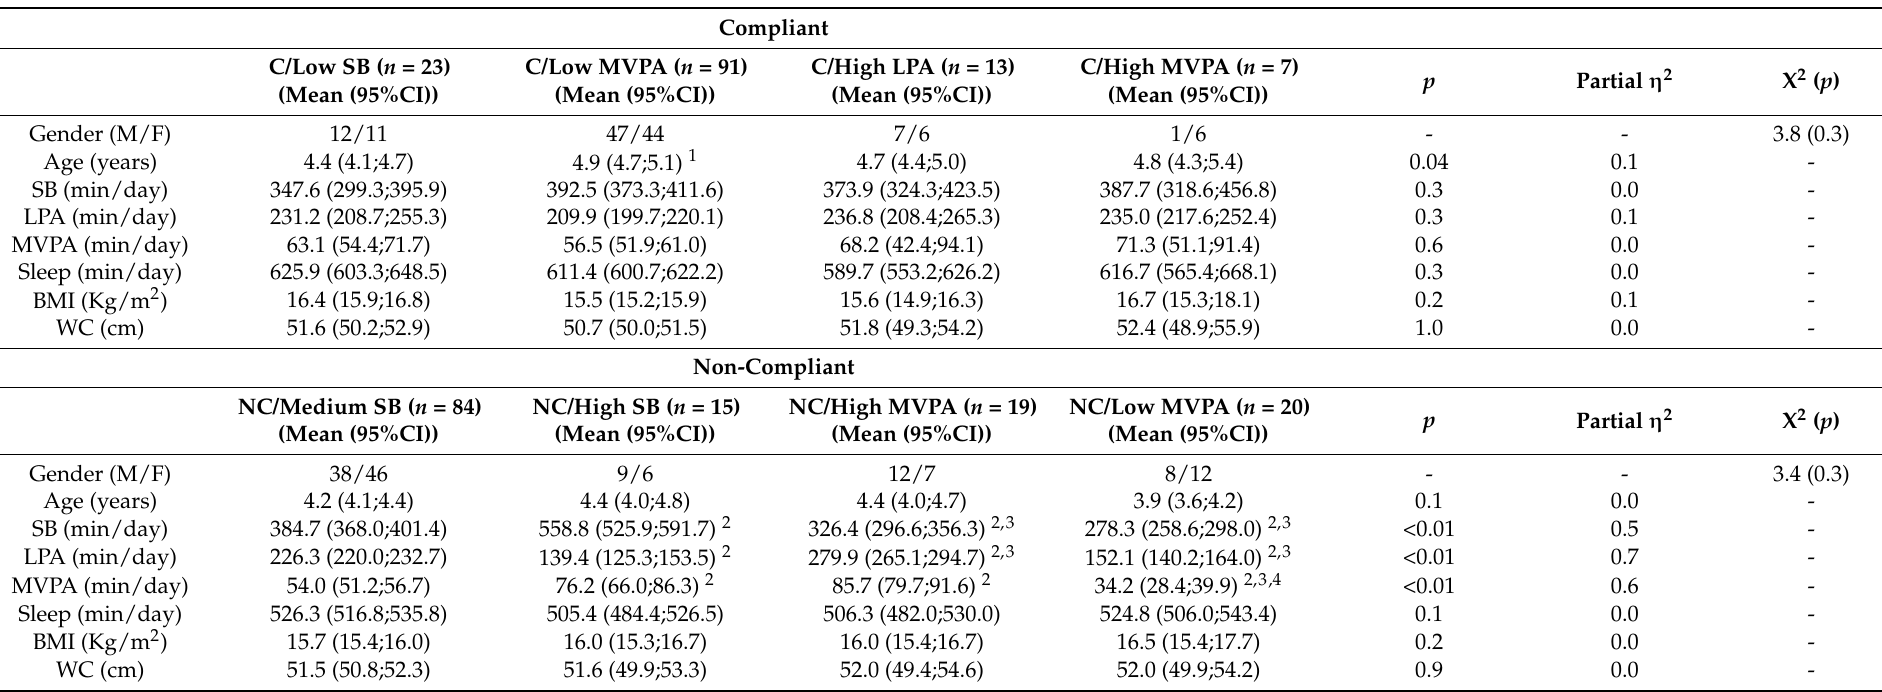
Table 3. Descriptive data of latent profile classes according to compliance with sleep